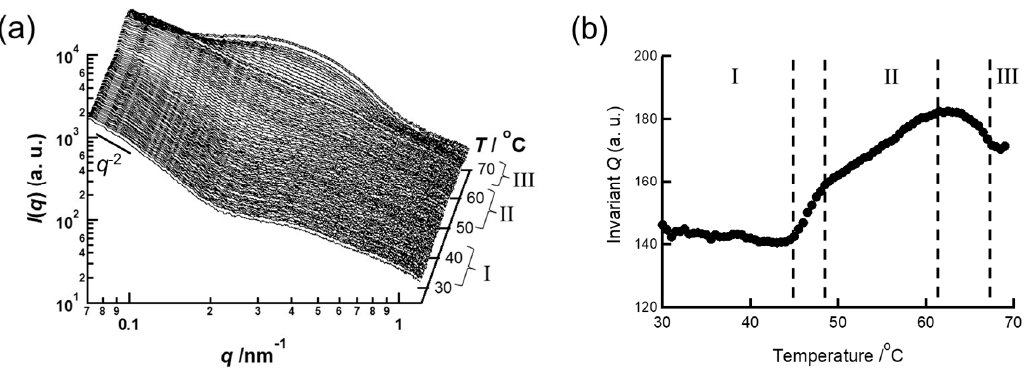
Figure 2. Changes in small-angle X-ray scattering (SAXS) profiles ( a ) and Invarian Q ( b ) of PVP- b -PODA micelles with elevating temperature.